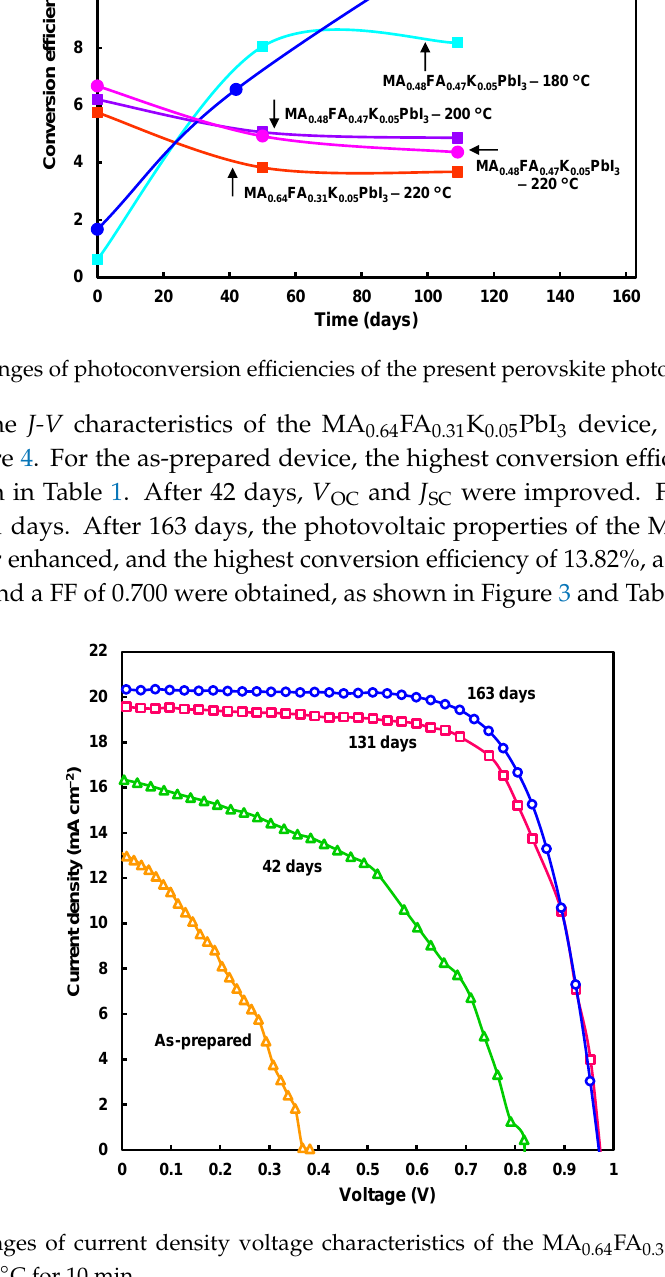
Figure 4. Changes of current density voltage characteristics of the MA 0.64 FA 0.31 K 0.05 PbI 3 device prepared at 180 °C for 10 min. Microstructural changes of the MA 0.64 FA 0.31 K 0.05 PbI 3 device annealed at 180 °C were investigated